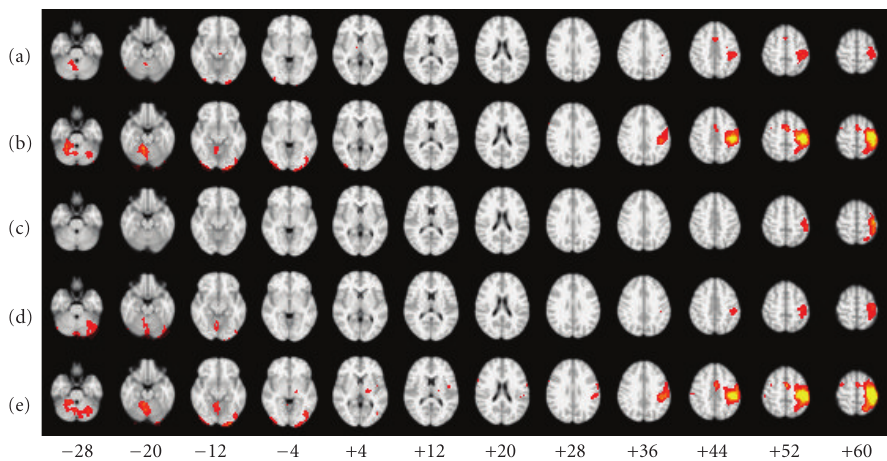
Figure 6: Group spatial maps derived from (a) task-related GLM; (b) group ICA, PICA, N = 14; (c) group ICA, Infomax, N = 14; (d) group ICA, PICA, N = 5; and (e) group ICA, PICA, N = 30. N is the number of ICs